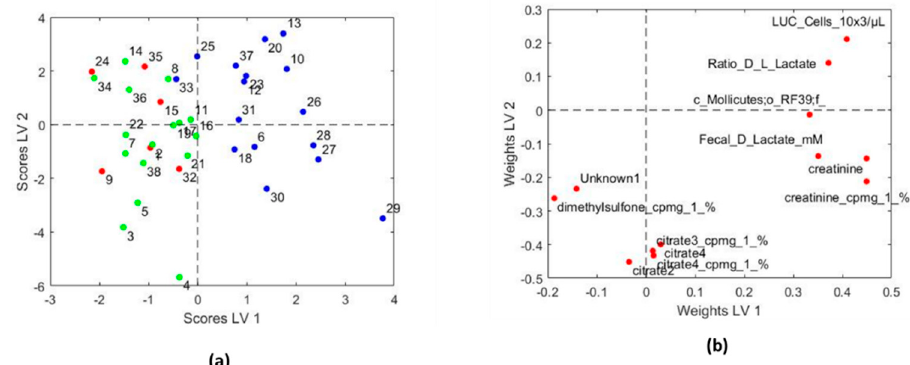
Figure 4. PLS-DA model from the variants selected by sPLS-DA model in terms of asthma severity. ( a ) score plot of the first two latent variables (LVs); Blue: Asthmatic children with persistent asthma, Green: Asthmatic children with frequent asthma, Red: Asthmatic children with occasional asthma; ( b ) weights plot of the first two LVs. Asthmatic children with persistent asthma showed higher values of the variables towards the upper right corner of the weights plot, and lower values of the rest, compared to the asthmatic children with occasional plus frequent asthma. Citrate 2–4 are several signals of the same metabolite. PLS-DA: Partial Least Squares Discriminant Analysis; sPLS-DA: sparse variant of the Partial Least Squares Discriminant Analysis; cpmg: metabolites found from the NMR spectra recorded using CPMG (Carr–Purcell–Meiboom–Gill) pulse sequence; LUC: large unstained cells.